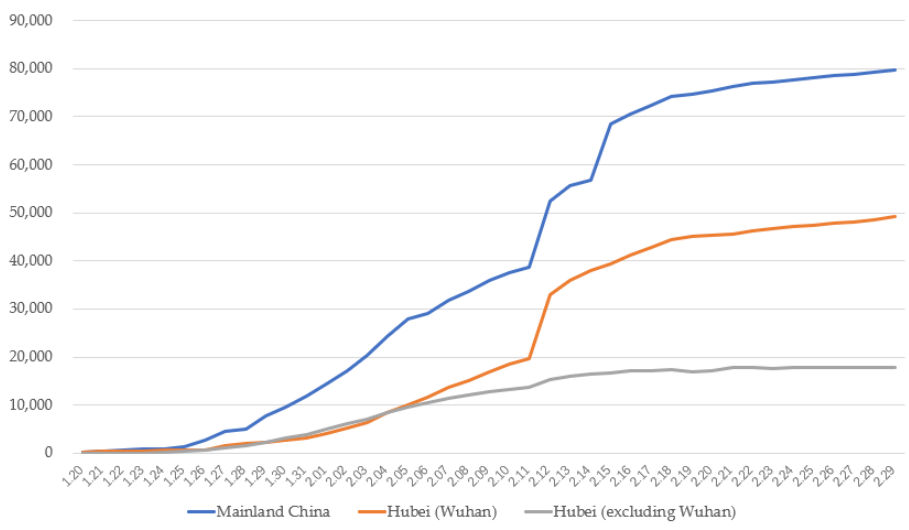
Figure 1. Number of confirmed cases in mainland China and Hubei Province from 20 January.